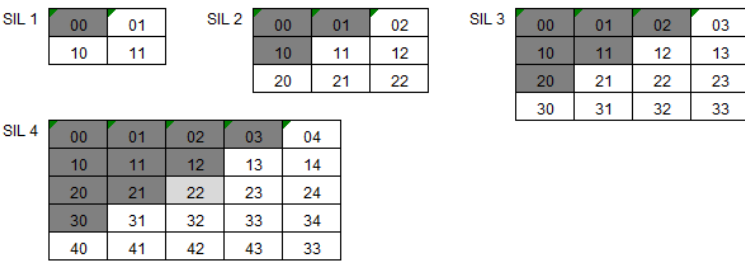
Fig. 3. Two-elements SIL AND